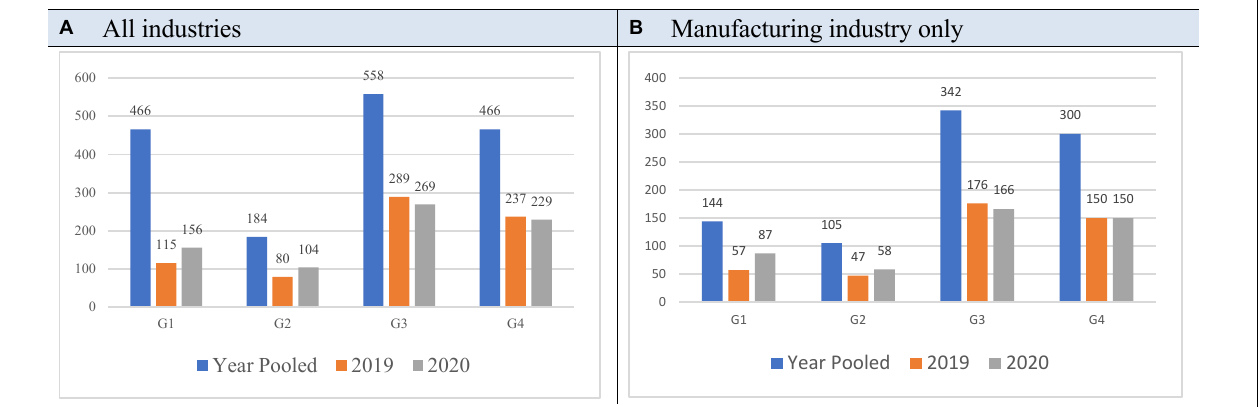
FIGURE 2 | Distribution of four groups (G1, G2, G3, and G4). a G1: ROE ↑ , ESG ↑ , G2: ROE ↓ , ESG ↑ , G3: ROE ↓ , ESG ↓ , G4: ROE ↑ , ESG ↓ .